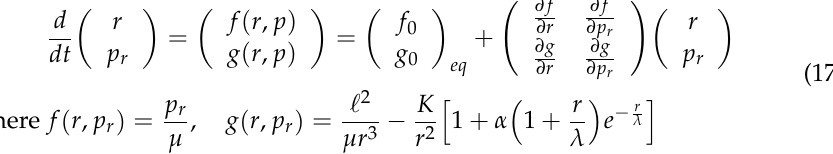
Figure 1. The reduced potential (red line) for fixed angular momentum (Equation (16)). The pink line denotes the magnitude of the purely Yukawa term ( the Keplerian reduced potential, i.e., Equation (16), without the Yukawa